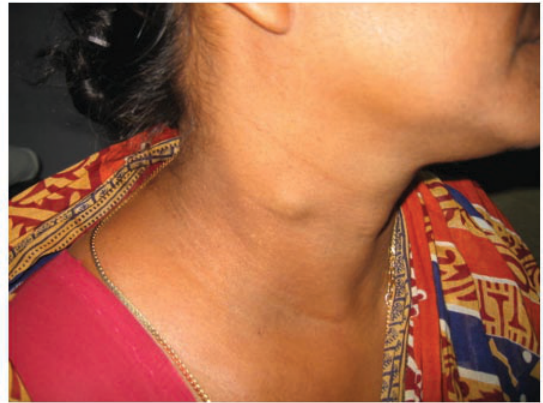
Figure 1. Venous aneurysm along the right external jugular